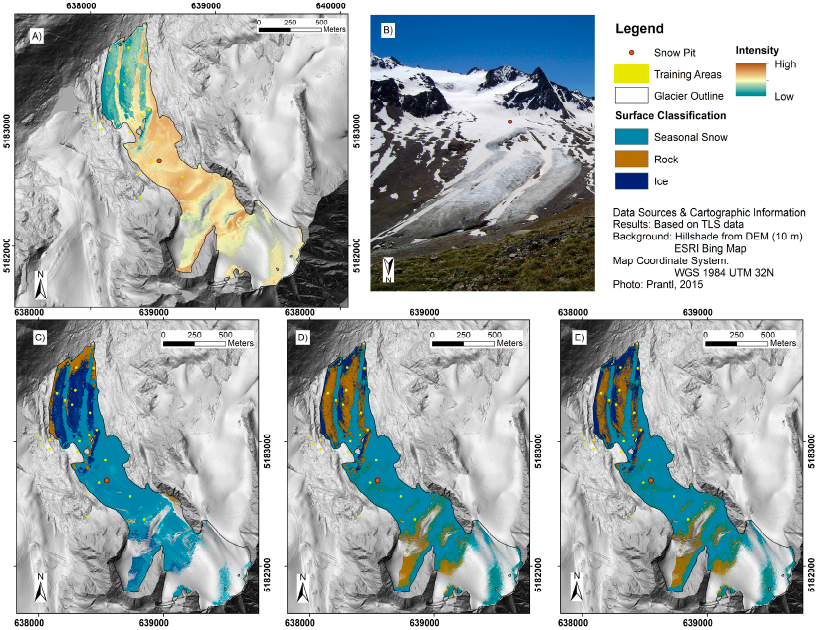
Figure 2. The ( A ) intensity (signal strength) raster layer, ( B ) photograph of the glacier (looking upglacier, in an approximately SSW direction) taken on 17 July 2017 (with the location of the snow pit), the ( C ) Rule-Based Classified (RBC), the ( D ) Maximum-Likelihood supervised Classified (MLC) and the ( E ) minimum distance supervised classified raster layer of 18 July 2014.